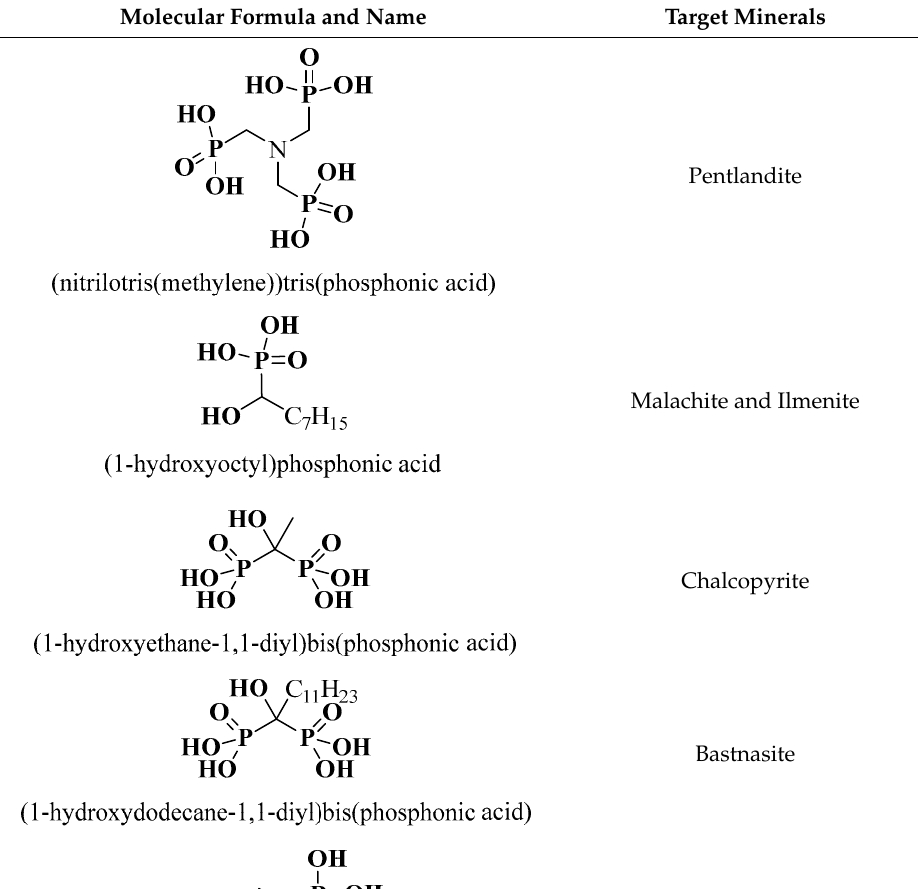
Table 1. Recent examples of phosphonic acid derivatives used as flotation collectors.